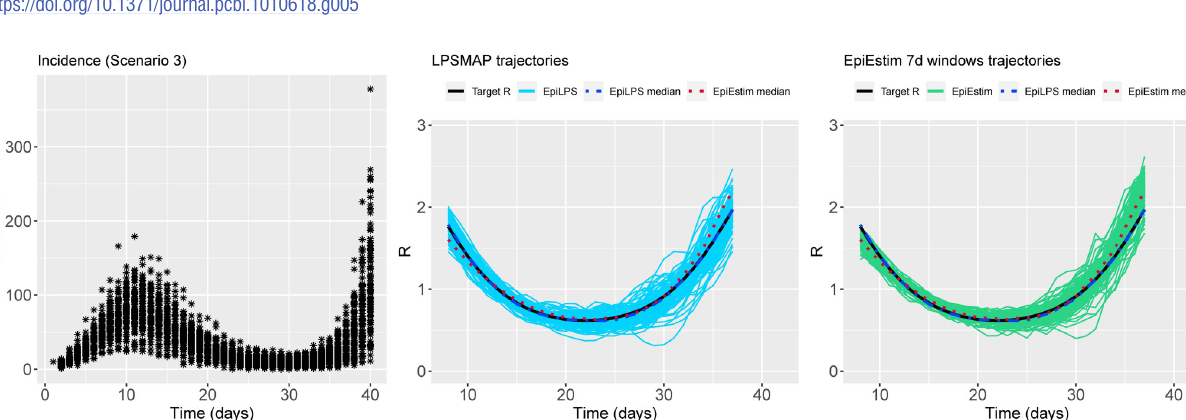
Fig 5. (Left) Simulated incidence data for Scenario 2. (Center) Estimated trajectories of R trajectories of R with EpiEstim using weekly sliding windows and R t (dashed) and EpiEstim (dotted) is also shown.